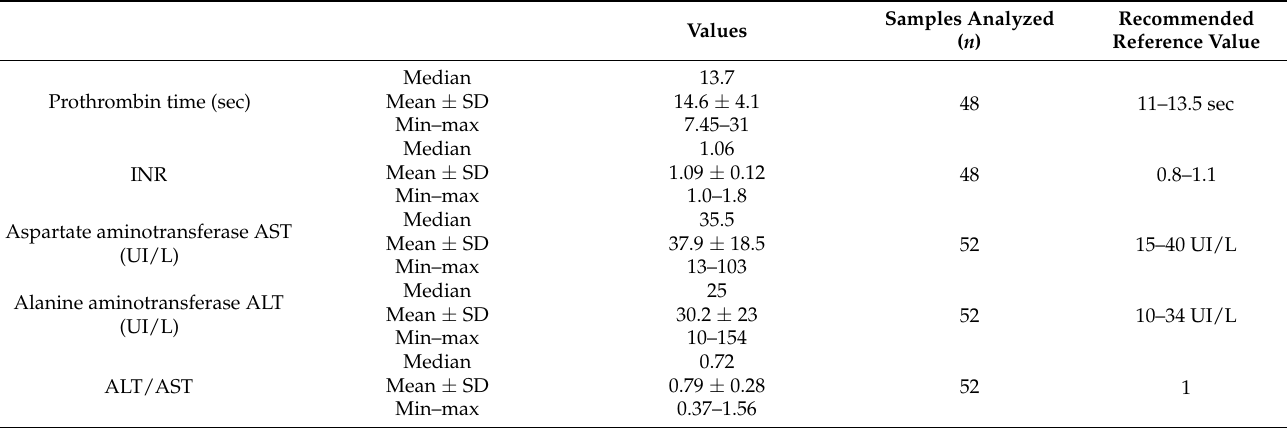
Table 4. Liver parameters over one year of follow-up in HT-1 patients.